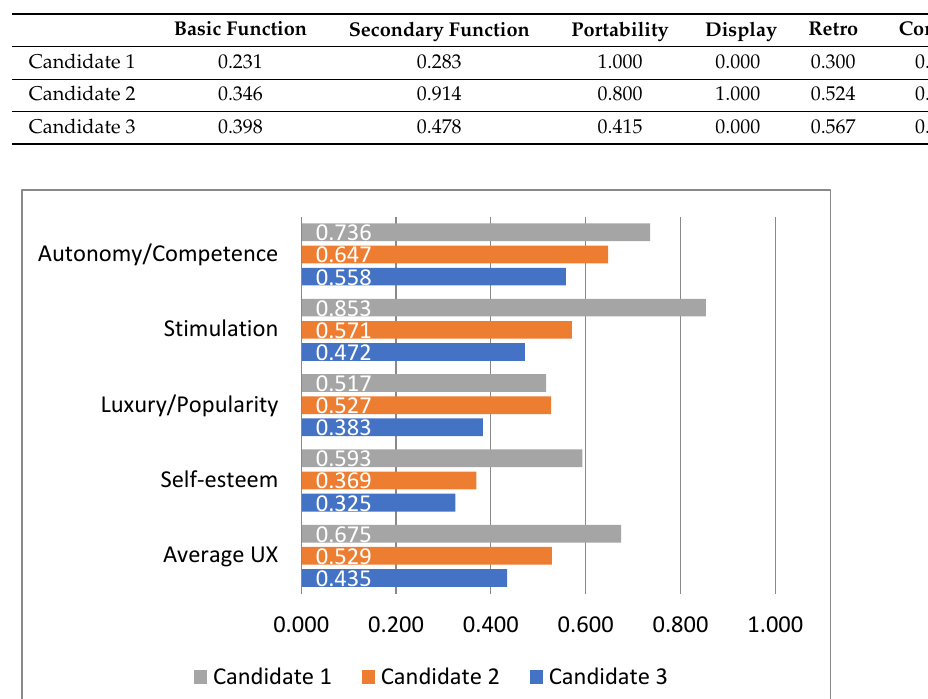
Figure 8. Predicted UX indicators of design specification candidates.